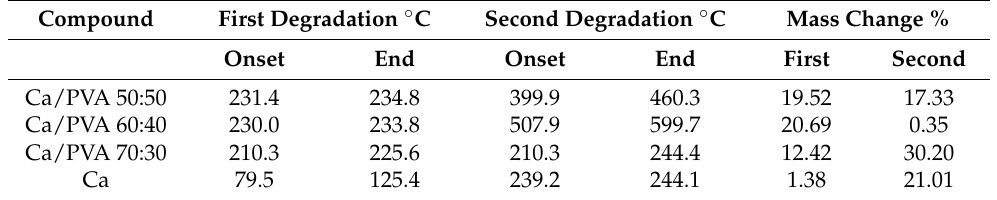
Table 2. The details of the TGA diagrams for Ca/PVA 50:50, Ca/PVA 60:40, Ca/PVA 70:30, and Ca hydrogels.